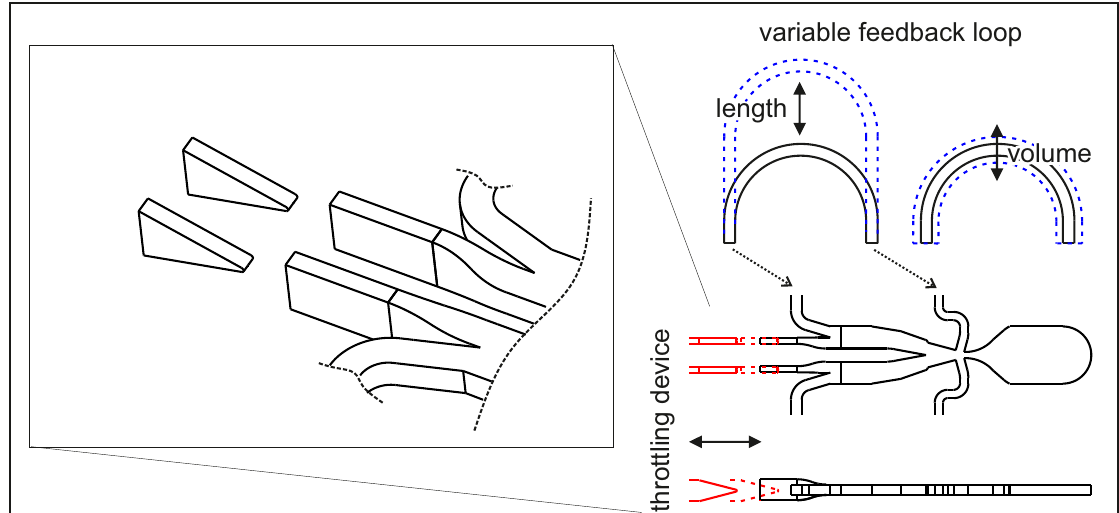
Figure 5. Variations of feedback loop and